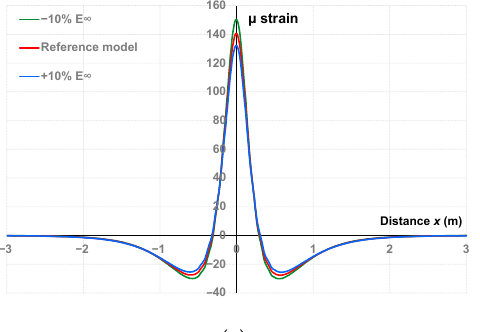
Figure 8. Fitting of the proposed numerical model to the reference signal with ( a ) ±10% variation for 𝐸 (cid:2998) , ( b ) ±10% variation for 𝐸 (cid:3022)(cid:3008)(cid:3014) .